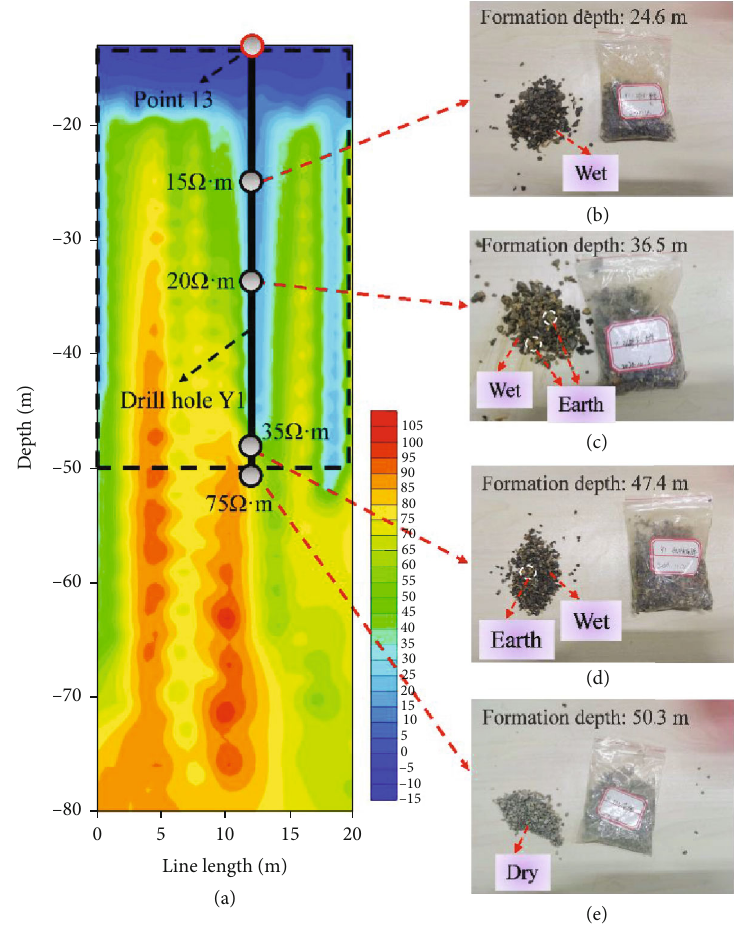
Figure 7: Slug samples at di ff erent formation